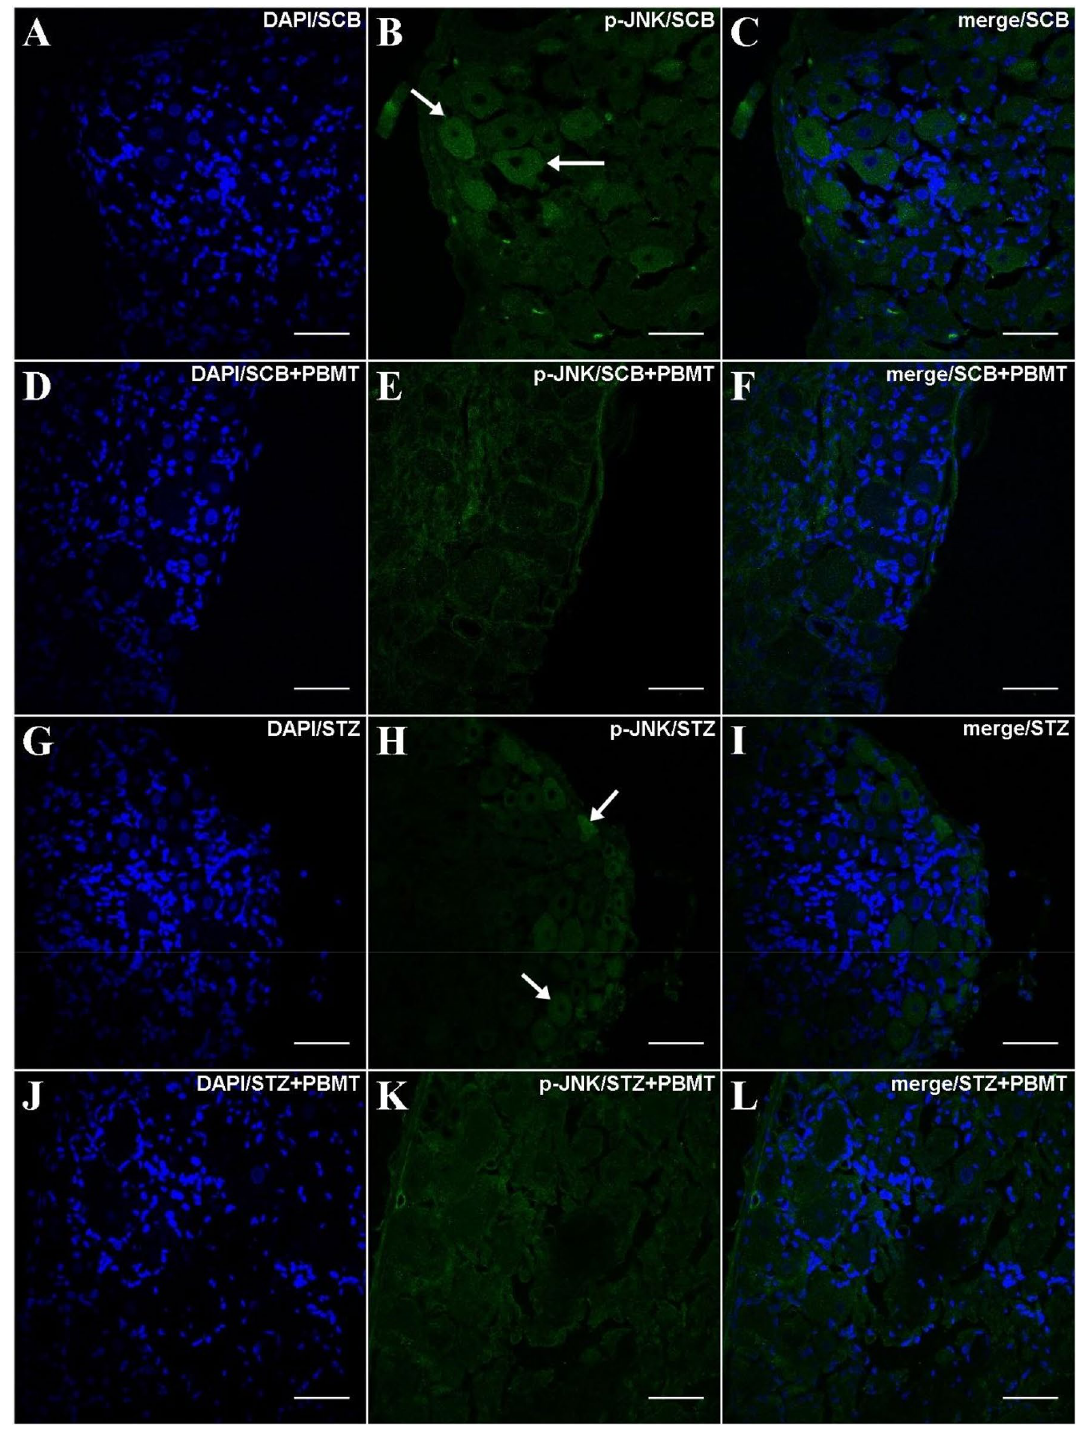
Figure 7. DRG histological micrographs of p-JNK MAPK by confocal microscopy. DRG transversal sections were 14 µm in thickness and submitted to IF protocol for staining of endogenous p-JNK phosphorylation in Thr183 and Tyr185 (p46/p54) ( B , E , H , K ). DAPI for nuclear staining is shown in ( A , D , G , J ). Merge (DAPI + p-JNK) images were also shown in ( C , F , I , L ). In ( B ) and ( H ), arrows point to diffused staining in the cytoplasm. Magnification: ×40; scale bars: 50